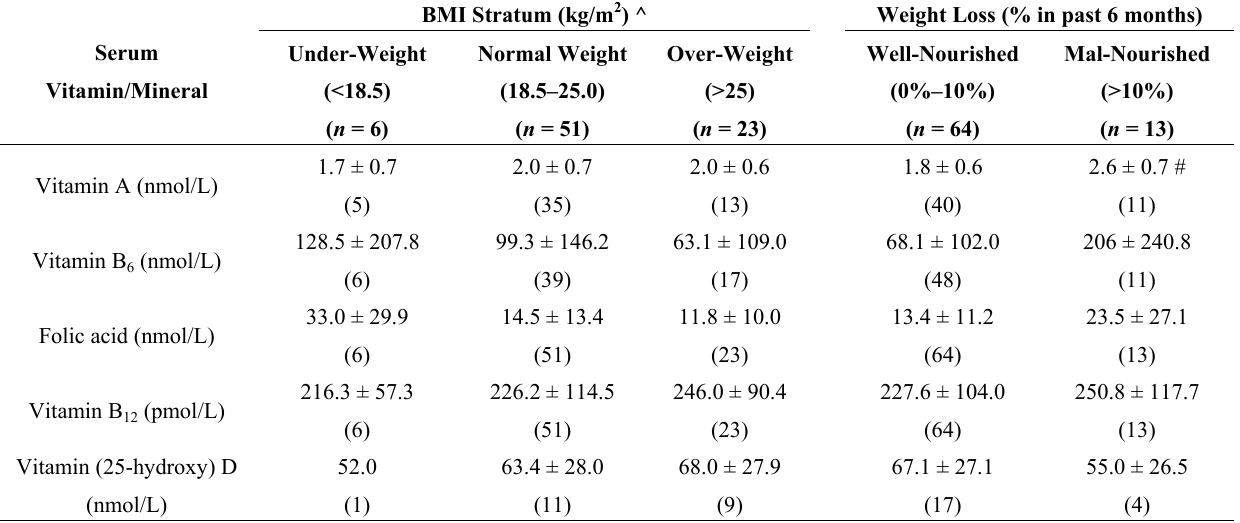
Table 5. Mean serum concentrations of vitamins and minerals (±SD) in untreated CD-patients by nutritional status (BMI stratum and unintentional weight